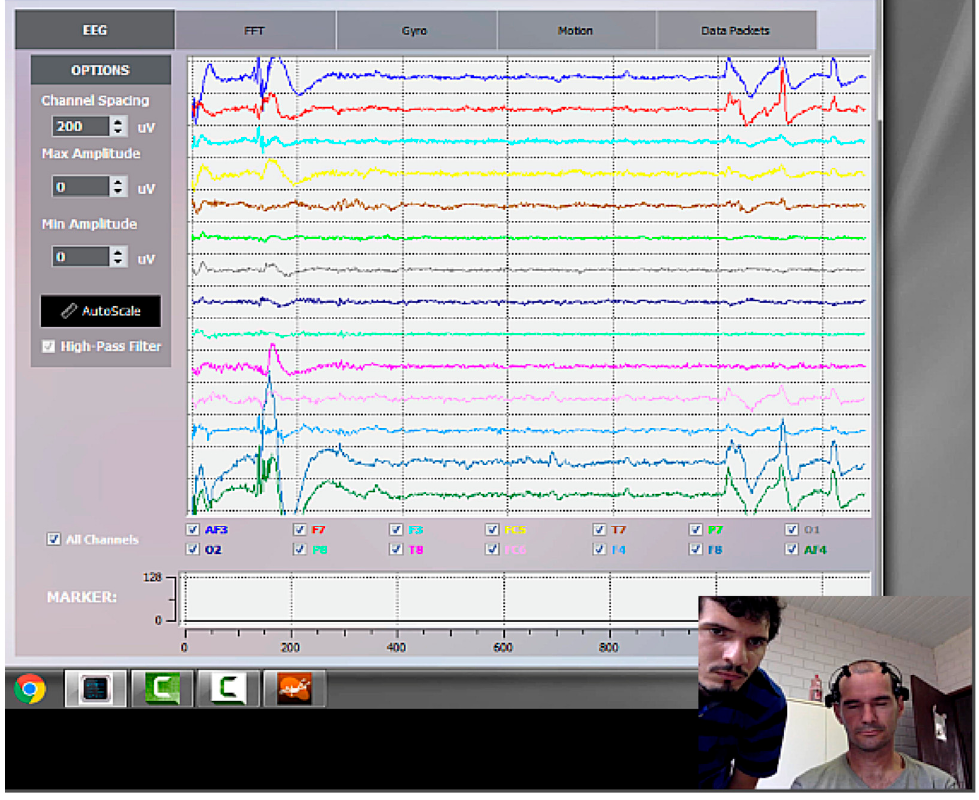
Figure 2. Emotiv Pure—Electroencephalography (EEG) raw interface.